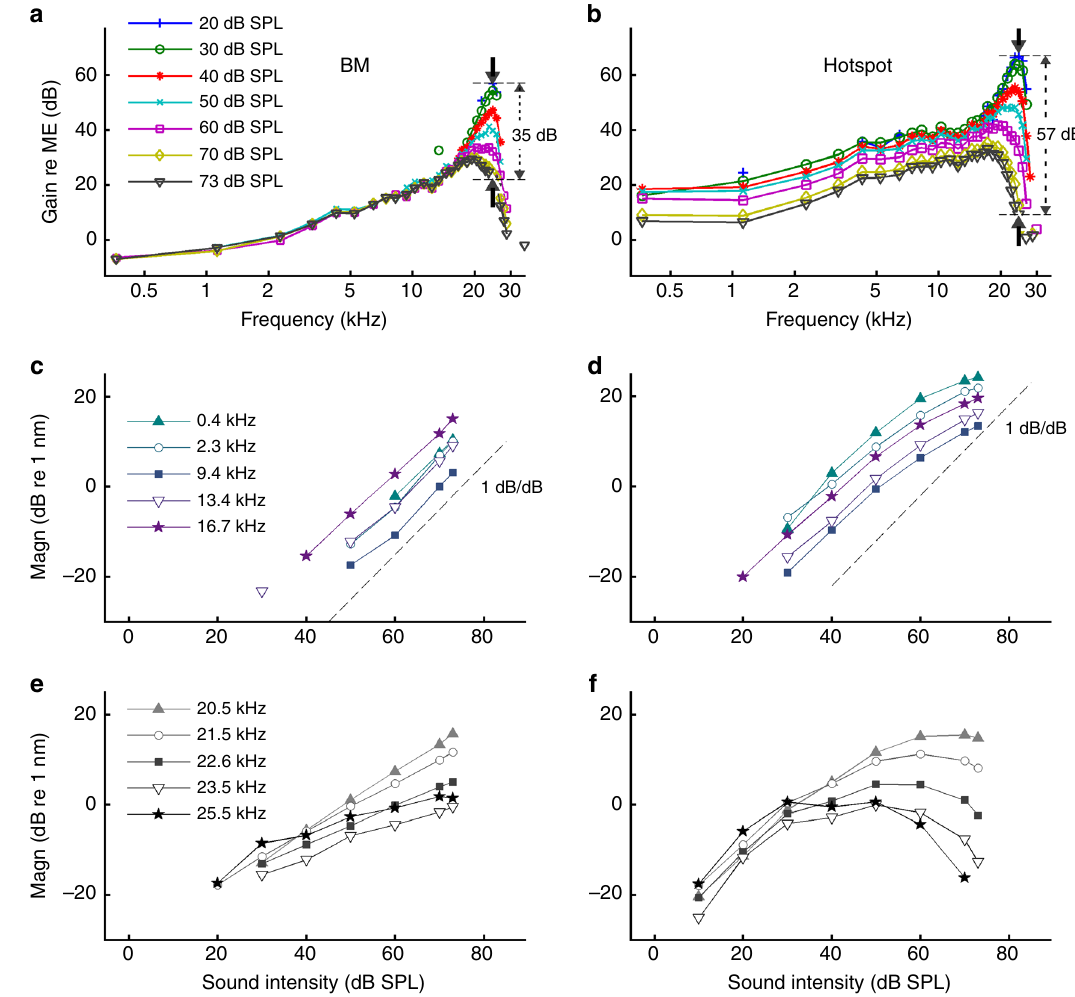
Fig. 6 Compression on the BM (left) versus hyper-compression in the hotspot region (right). a , b Vibration magnitude as a function of frequency, normalized to stapes motion. Sound intensity is indicated in the key, with arrows indicating amounts of compression observed at CF (25 kHz) between 20 and 73 dB SPL. c , d Below-CF input – output functions for different frequencies, based on the tuning curves of panels a , b . Dashed lines illustrate linear growth for reference. e , f Near-CF input – output functions. Data were obtained from a single preparation (the same one as in Fig. 5, CF 25 kHz), and acquisition from the two locations was